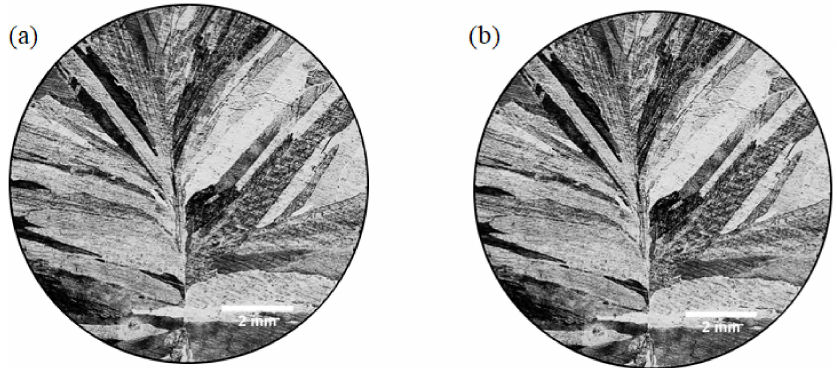
Figure 5. Macrostructures of the as-cast ( a ) pure Mg and ( b ) Mg-3Y alloys.